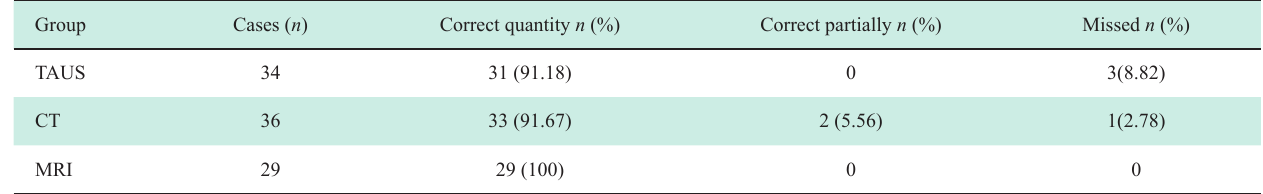
Correct localization n (%)